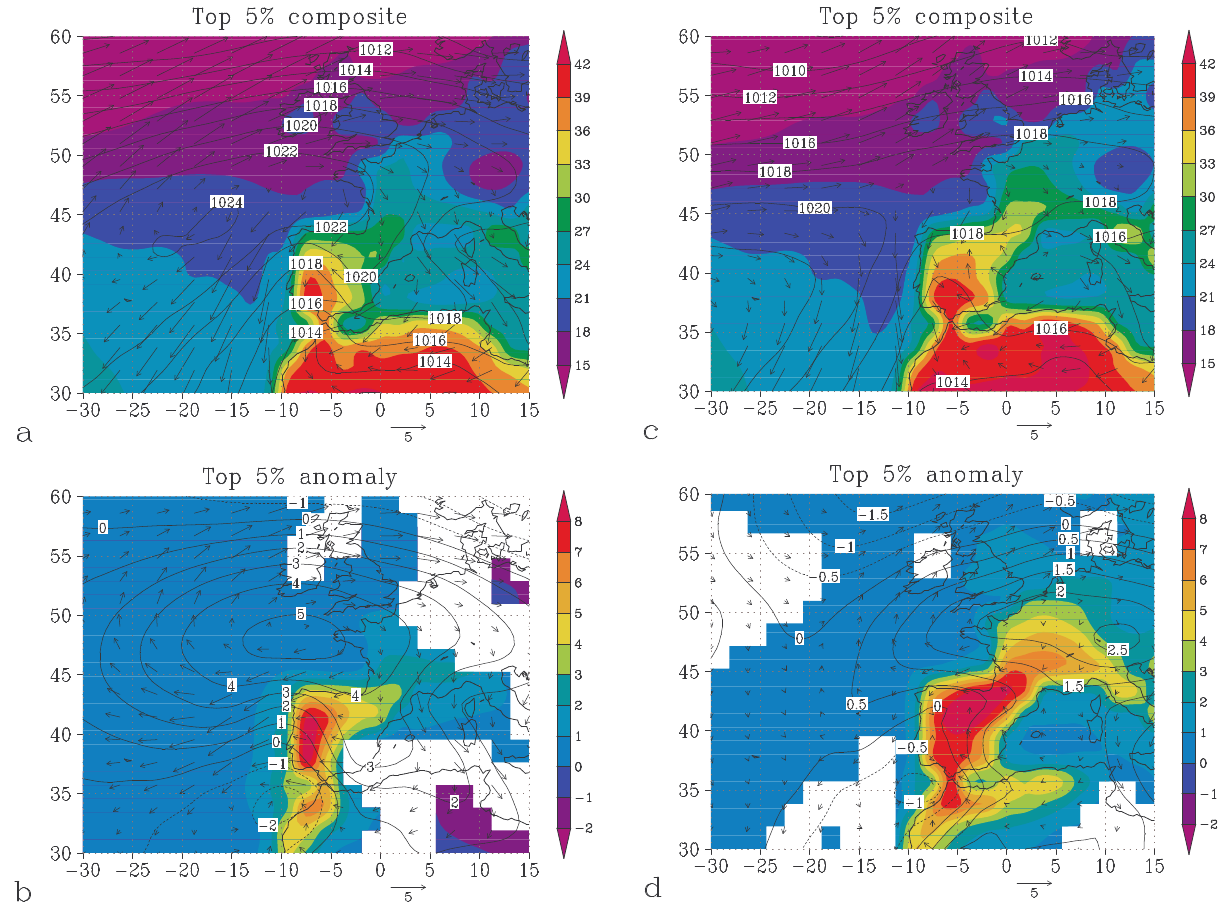
Fig. 6. Composite of T max in shaded colour ( ◦ C) for ( a ) Lisbon, and ( c ) Madrid. Contour lines and arrows show, respectively, the associated SLP (mb) and 10 m height wind (m/s) fields. All data correspond to the longer period between 1958 and 1977. The corresponding top 5% anomaly composites, after removing the summer average, are represented in ( b ) Lisbon and ( d ) . The T max anomaly field represented only in those areas where such an anomaly is significant at the 5% level (or 95% confidence level) computed with a two-tailed